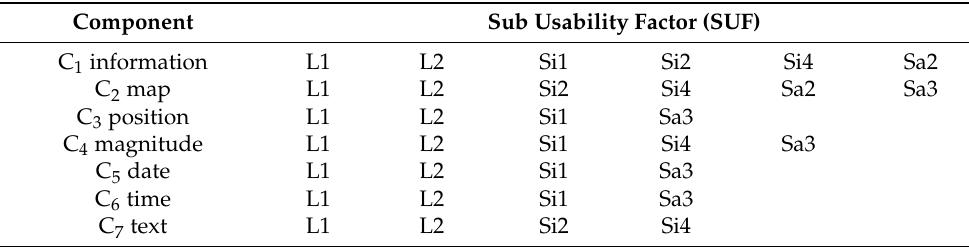
Table 7. The design checklist.